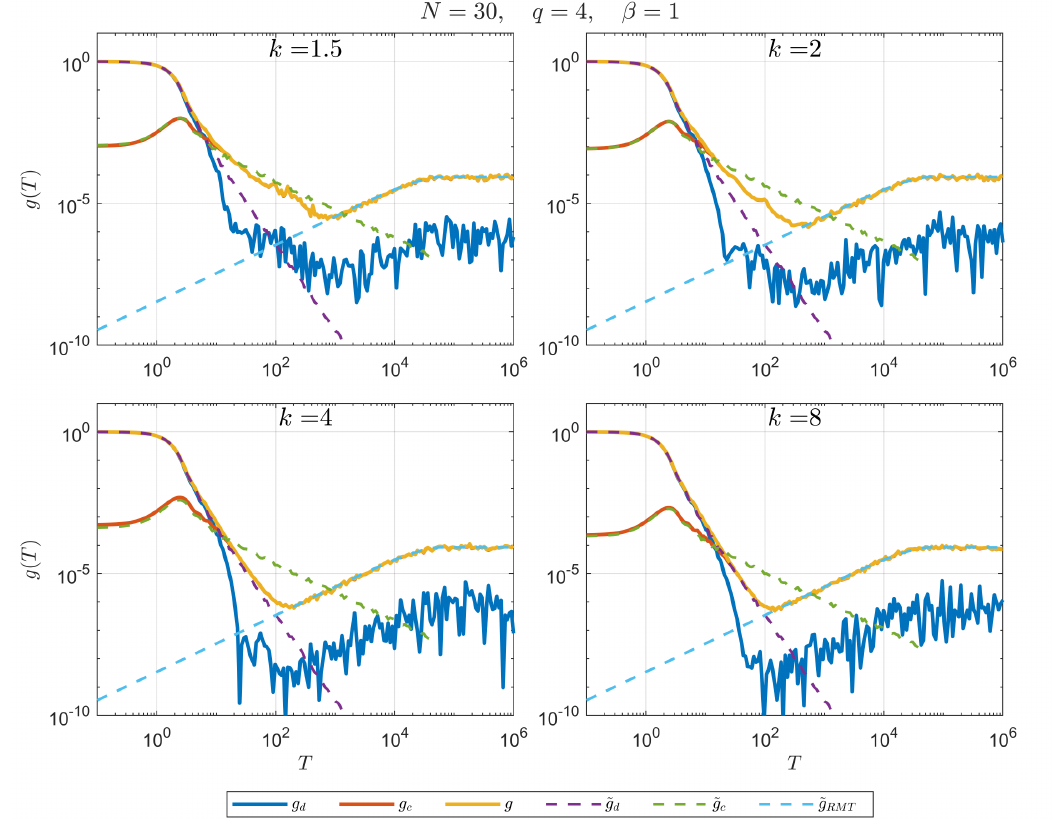
Figure 4 . Full spectral form factor g , connected part g c , and disconnected part g d , obtained by exact diagonalization of the sparse SYK Hamiltonian define over a regular hypergraph, and averaged over 100 disorder realizations of the random couplings. These are compared to the analytical Q – Gaussian approximation ˜ g , ˜ g , and ˜ g c d RMT